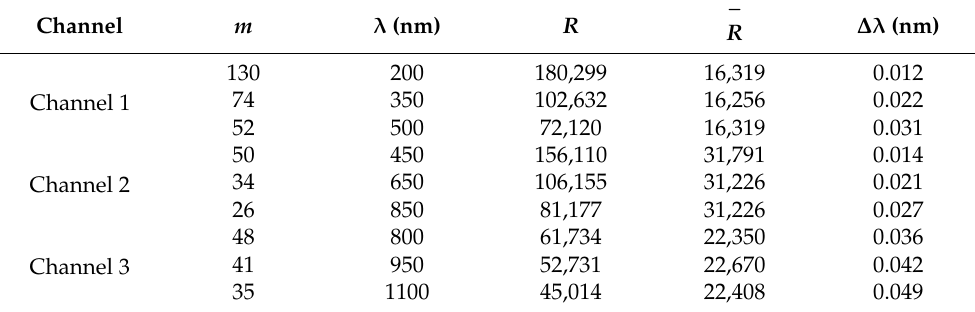
Table 4. Resolution of edge and center